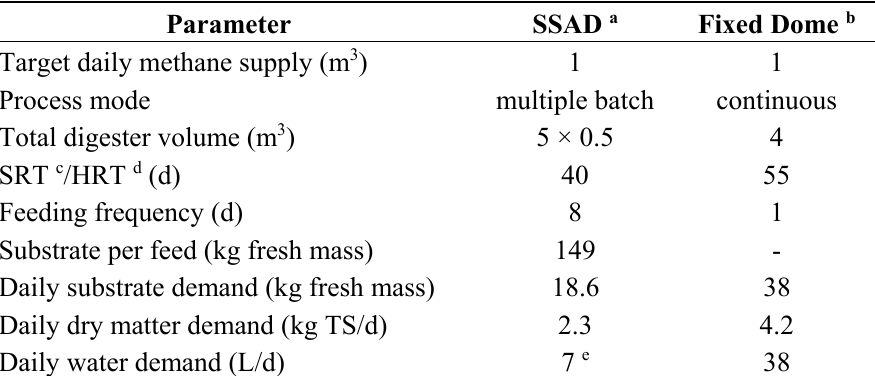
Table 5. Comparison of SSAD and fixed dome